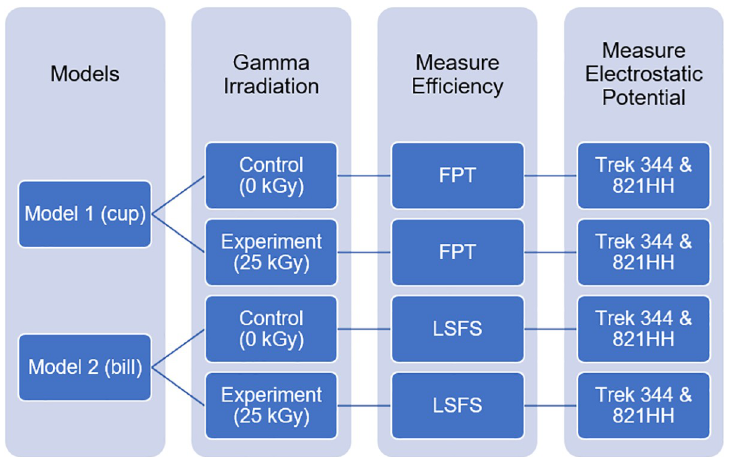
Fig 3. Summary of experimental methods. Abbreviations: FPT, Filter Penetration Testbed; LSFS, Large-scale filtration